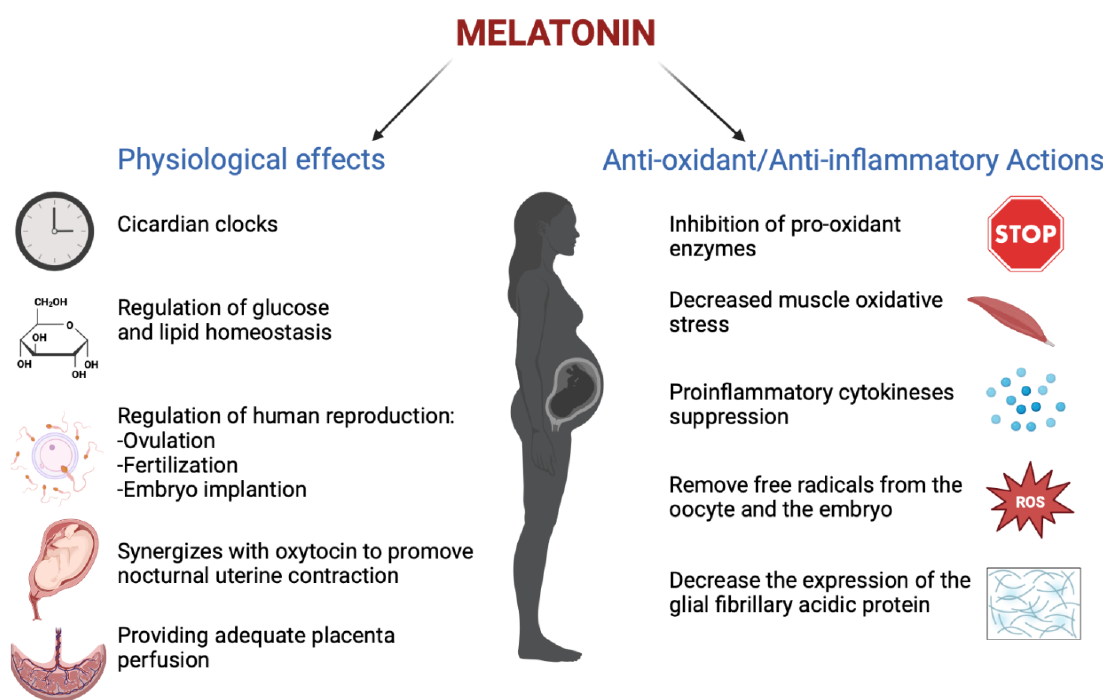
Figure 2. The physiological functions performed by melatonin in pregnancy (Created with BioRen-